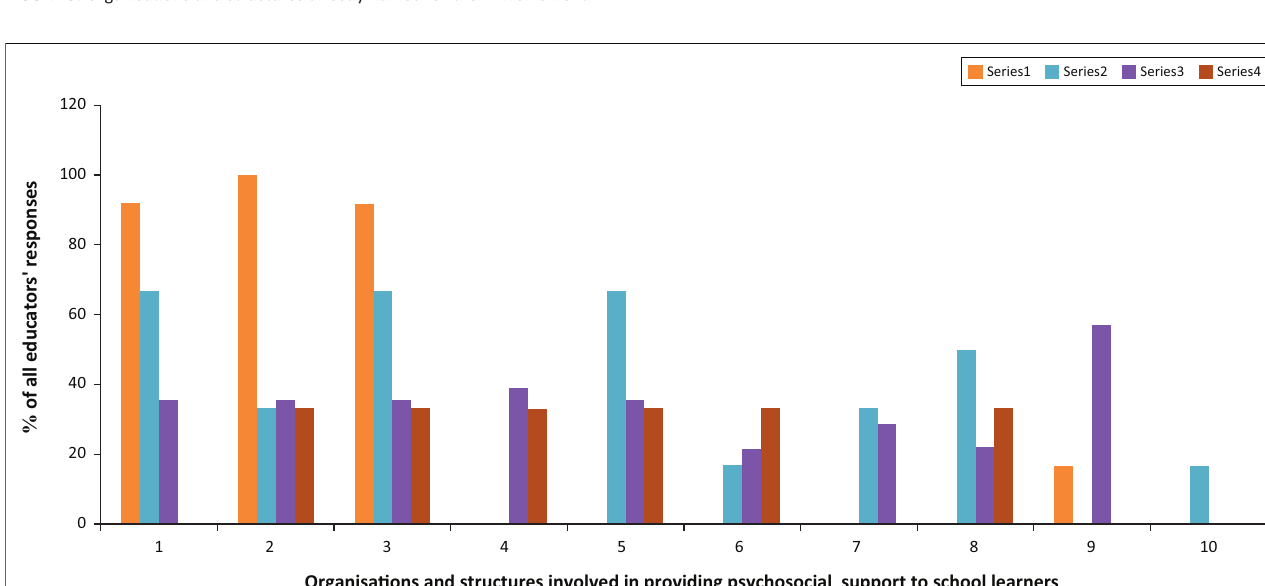
FIGURE 3: Organisations and structures directly named for their